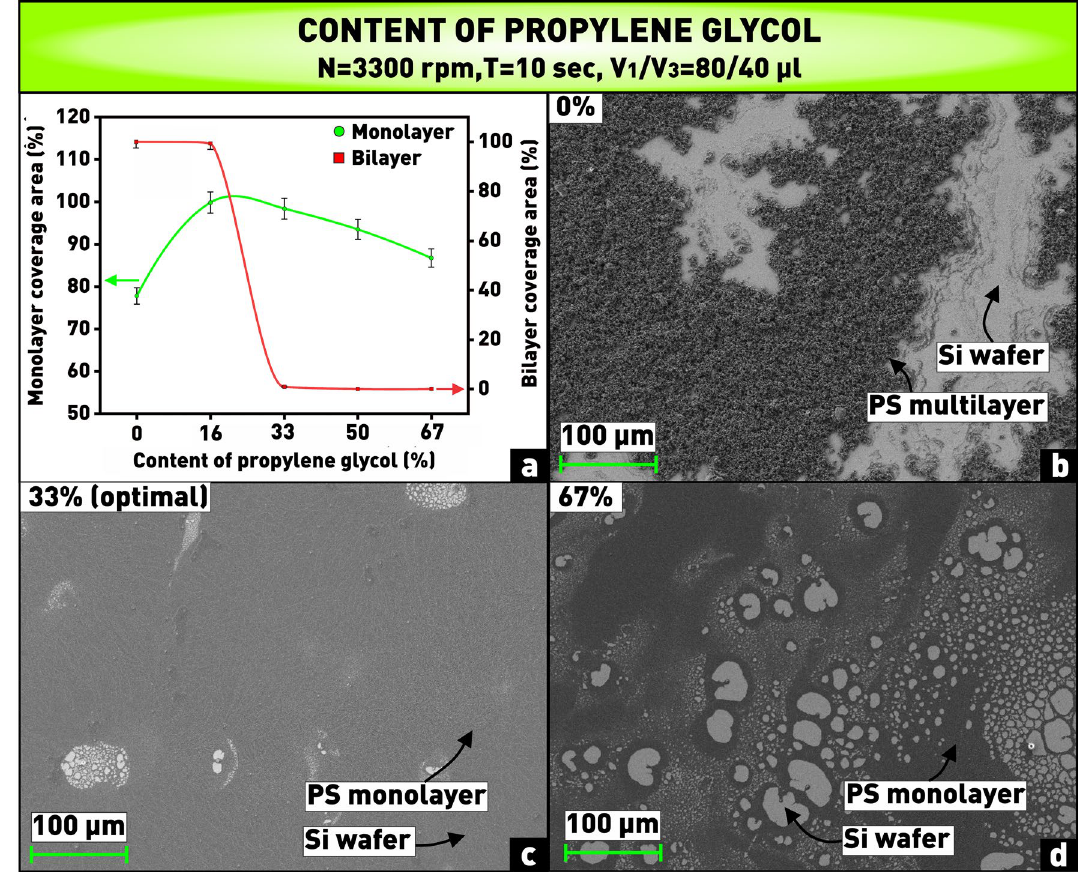
Figure 6. (a) Plot of dependence of substrate coverage area by monolayer and bilayer of PS nanospheres on content of propylene glycol in solution; (b–d) microphotographs of nanosphere coatings obtained at varying content of propylene glycol in